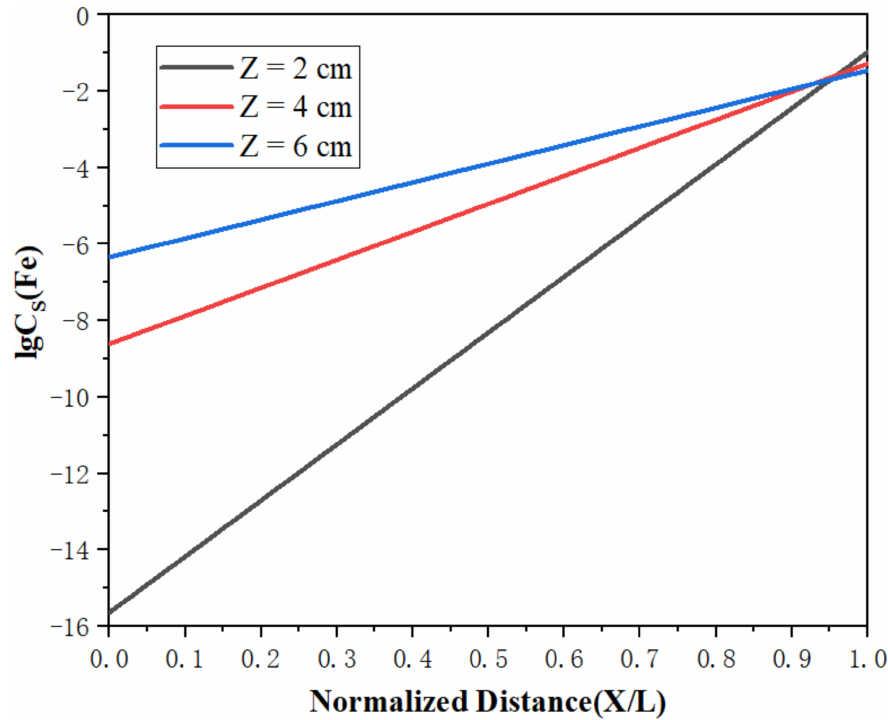
Figure 13. Limiting distribution of